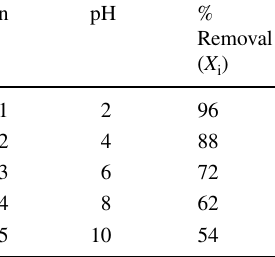
1 ) and solution temperature (